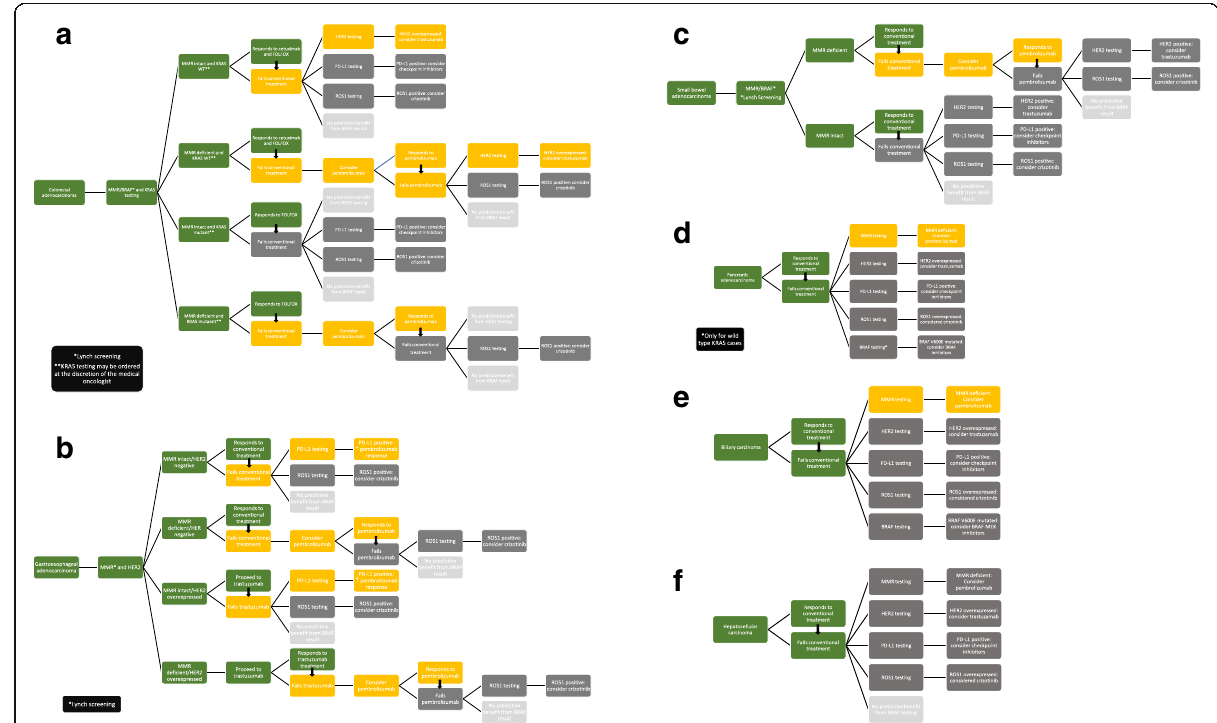
Fig. 1 Evidence-based suggestions to aid decision making for off-label predictive and prognostic biomarkers in malignancies of the gastrointestinal tract. There are three degrees of evidence: high (green), intermediate (yellow), low (dark grey) and no evidence (pale grey). Based on tumor type: a ) colorectal adenocarcinoma, b ) gastroesophageal adenocarcinoma, c ) small bowel adenocarcinoma, d ) pancreatic adenocarcinoma, e ) biliary adenocarcinoma and f ) hepatocellular